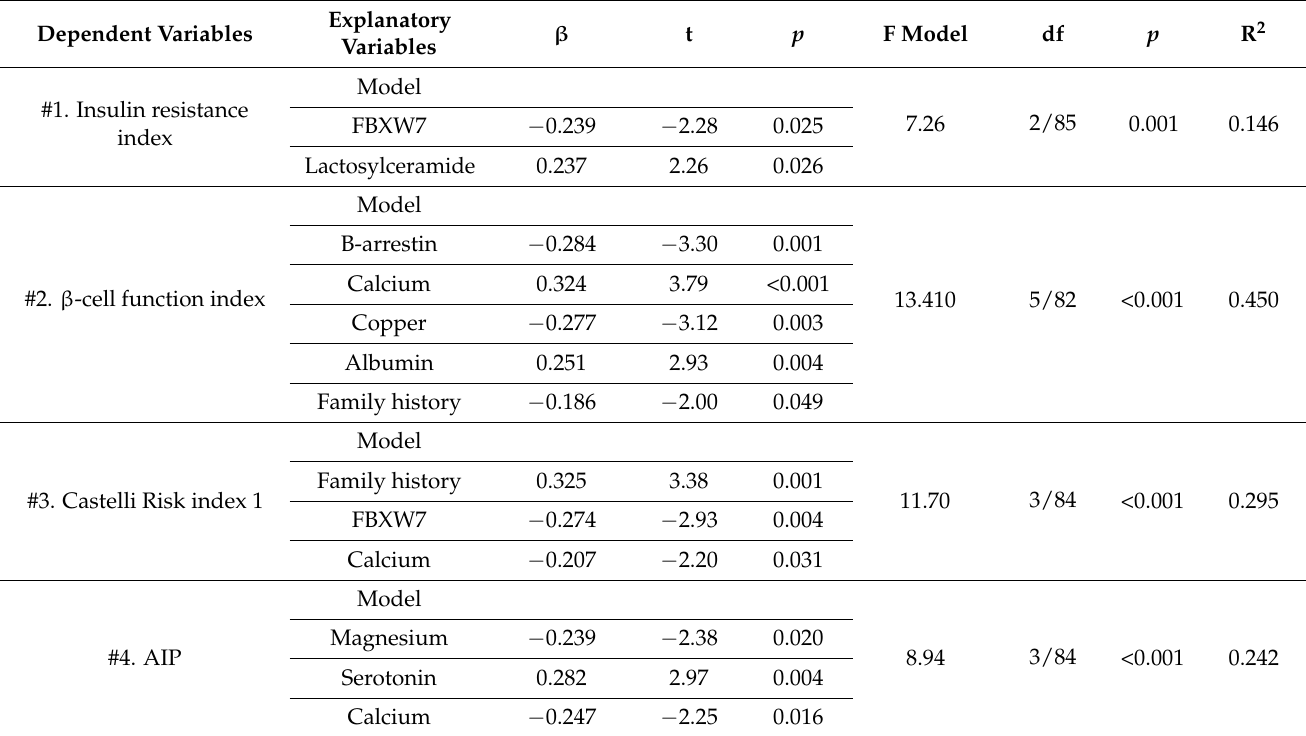
Table 6. Results of multiple regression analysis with insulin resistance, β -cell function, Castelli risk index 1, and atherogenic index of plasma (AIP) as dependent